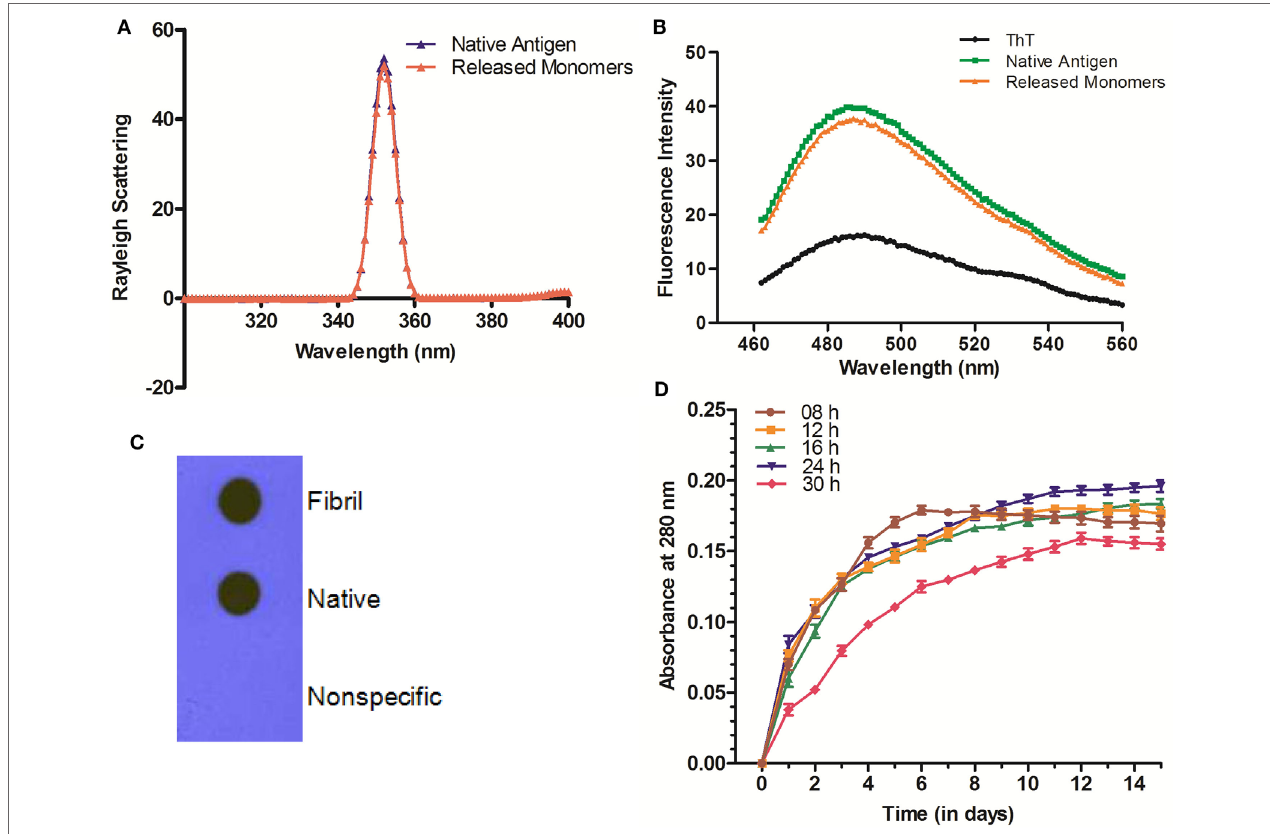
FigUre 2 | Biophysical properties and release profile of monomeric Ag85B released from fibrillar aggregate. (a) Rayleigh Scattering profile of released antigen. Rayleigh Scattering characteristics of monomeric Ag85B, released from aggregated amyloidal core, had biophysical properties overlapping to that of native, free form of antigen. (B) ThT binding profile of released monomeric Ag85B. Monomeric Ag85B pooled from in vitro release assay was scanned between 460 and 560 nm. The ThT-binding profile of released monomeric Ag85B from fibrillar depot displayed characteristic fluorescence spectra similar to that of the precursor native antigen. The experiment was repeated thrice and same results were obtained each time. (c) Dot blot assay to ascertain antibody specificity. Antibodies generated upon immunization with aggregated Ag85B were reacted with both- precursor native as well as released monomeric form of Ag85B from amyloidal depot. A non-specific protein (bovine serum albumin) was coated onto membrane as a control and allowed to react with the same antibody. Data are representative of three independent experiments with similar observations. (D) Aggregated Ag85B depot releases monomeric native precursor in the surrounding milieu in a sustained manner. In vitro release kinetics of Ag85B from its various time point aggregated forms as well 24 h fibril over a period of 15 days. Three independent experiments were carried out and data are reported as means of two independent experiments with similar observations, where error bars represents ± standard errors of means ( ±